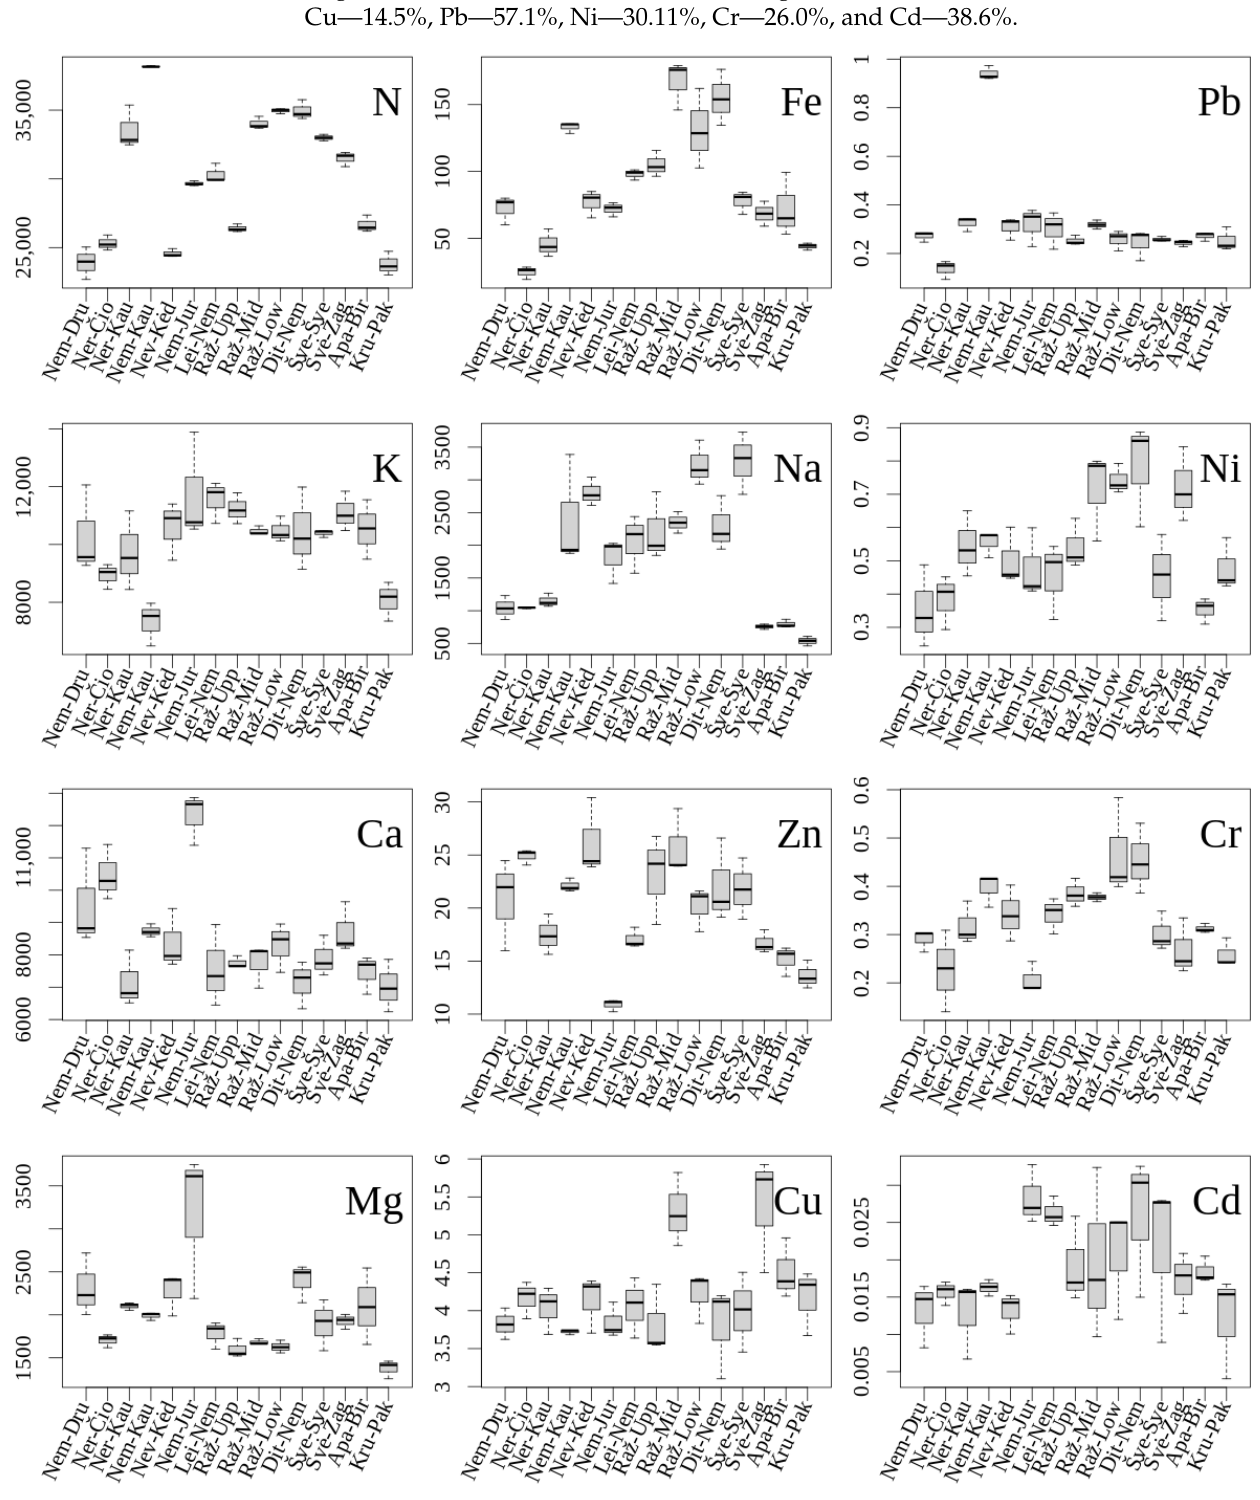
Figure 2. Median values (box–whisker plots) of the leaf element concentrations (µg/g d. m. in y axes) in L. salicaria populations in Lithuania. The central line of each box indicates the median value; the boxes, the lower (25%) and upper (75%) quartiles; and the whiskers are from the 10th to 90th percentiles (typical range). The median (central horizontal line) with 25/75 percentiles (boxes), 10/90 percentiles (bars); the number of replicates per population n = 3.